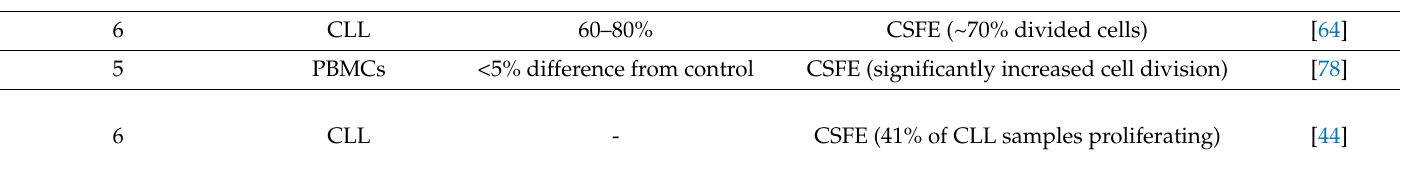
* In the brackets are results from control CLL samples cultured in standard